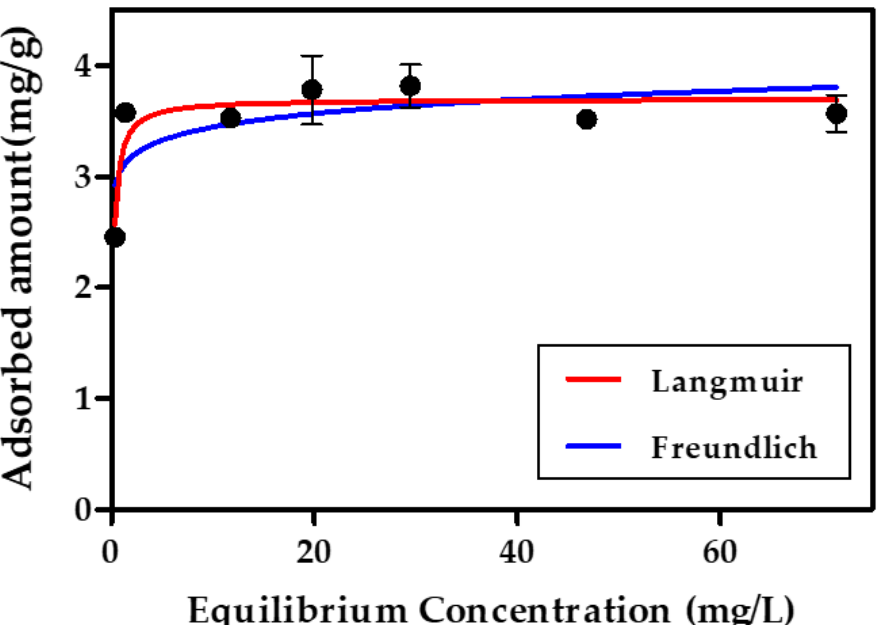
Figure 10. MB isotherm of GO/PLA filter obtained under the following experimental conditions: [MB] 0 = 0.37–71.5 mg/L, weight of added GO/PLA adsorbent for MB isotherm = 0.2 g, volume = 25 mL. Black dots represent the raw data which were used for fitting either Langmuir or Freundlich model. Table 2. Langmuir and Freundlich isotherm constants and values of MB adsorption on GO/PLA. Langmuir Isotherm